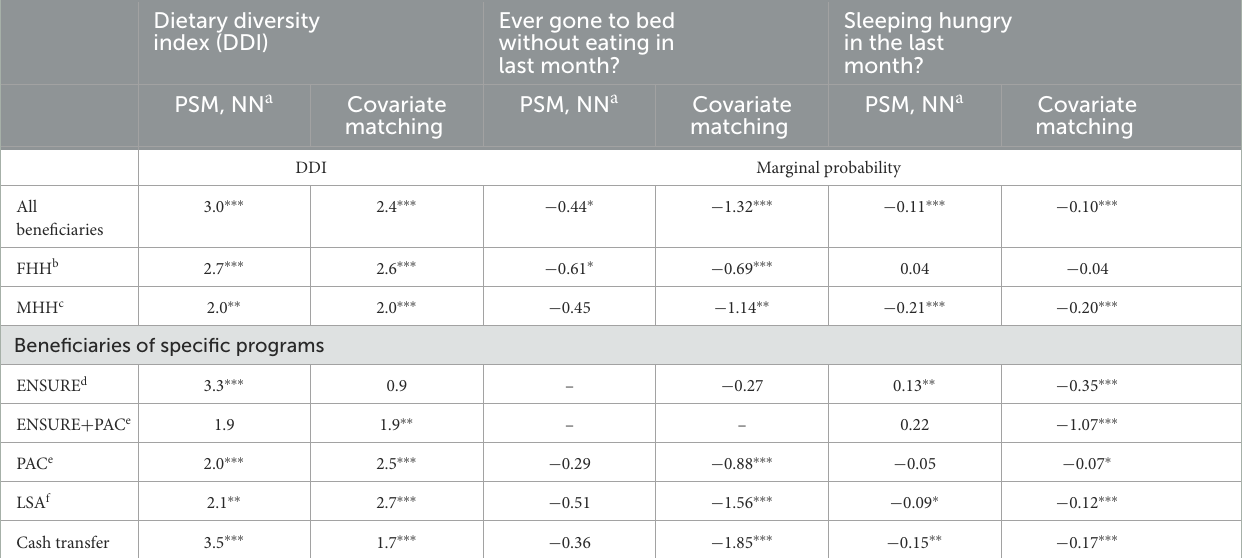
TABLE 9 Impact of WVZP on nutrition. Dietary diversity index (DDI)